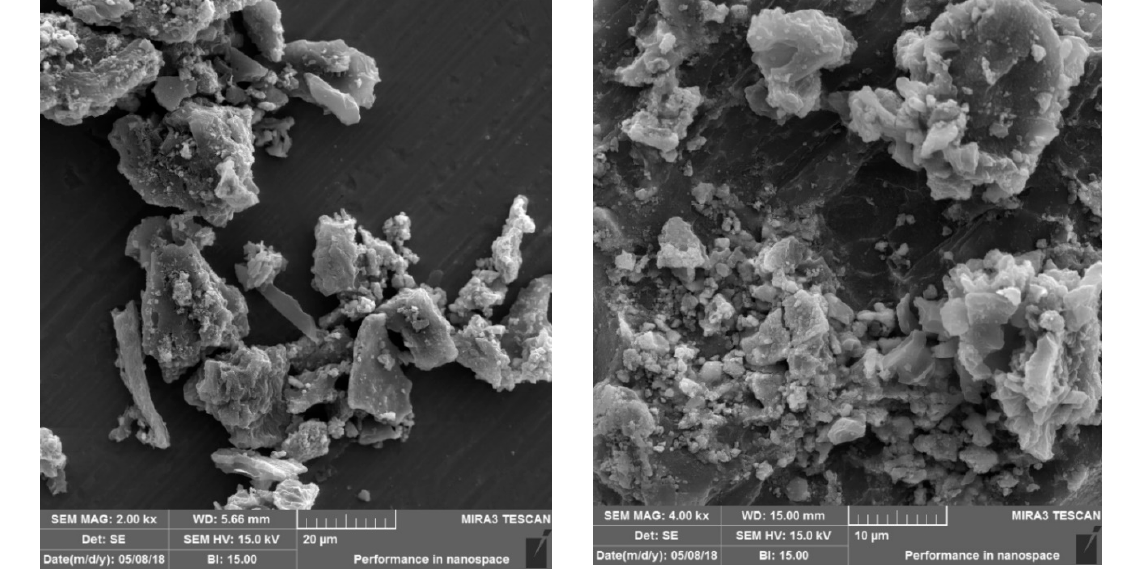
Figure 1. Field Emission Scanning Electron Microscopy (FE-SEM) images of activated carbon/CoFe 2 O 4 nanocomposite.